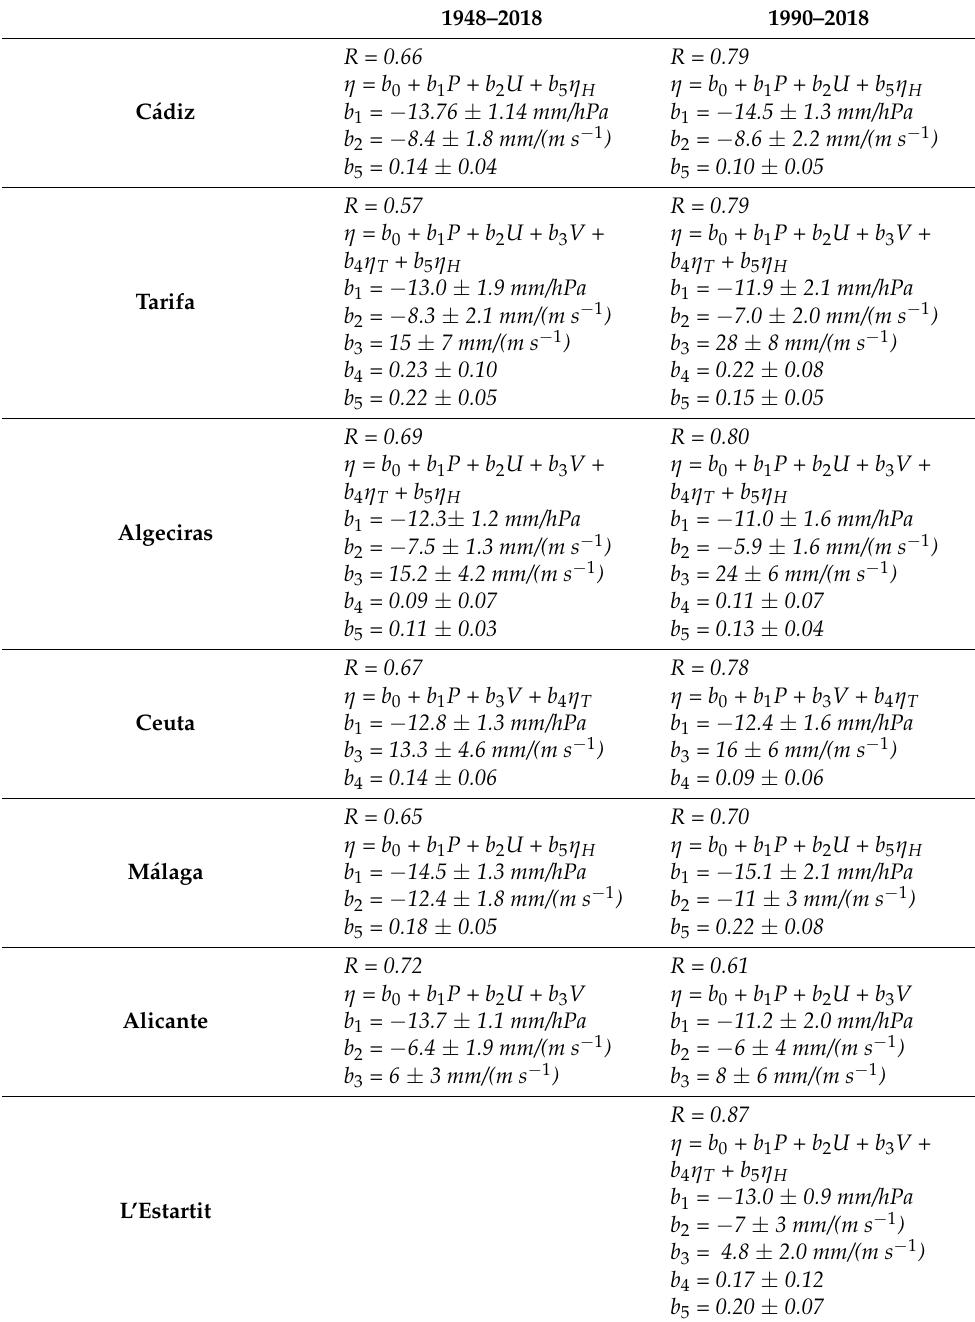
Table 4. Linear model selected by the forward stepwise multiple linear regression for the de-seasoned and de-trended sea level at C á diz, Tarifa, Algeciras, Ceuta, M á laga, Alicante, and L’Estartit. The multiple correlation coefficient (root square of the explained variance) and the 95% confidence intervals for the coefficients in the model are also